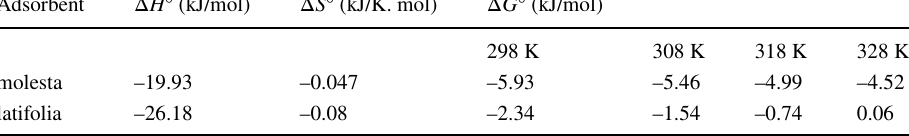
Table 3 Thermodynamic parameters for adsorption of Cr 6+ on S. molesta and